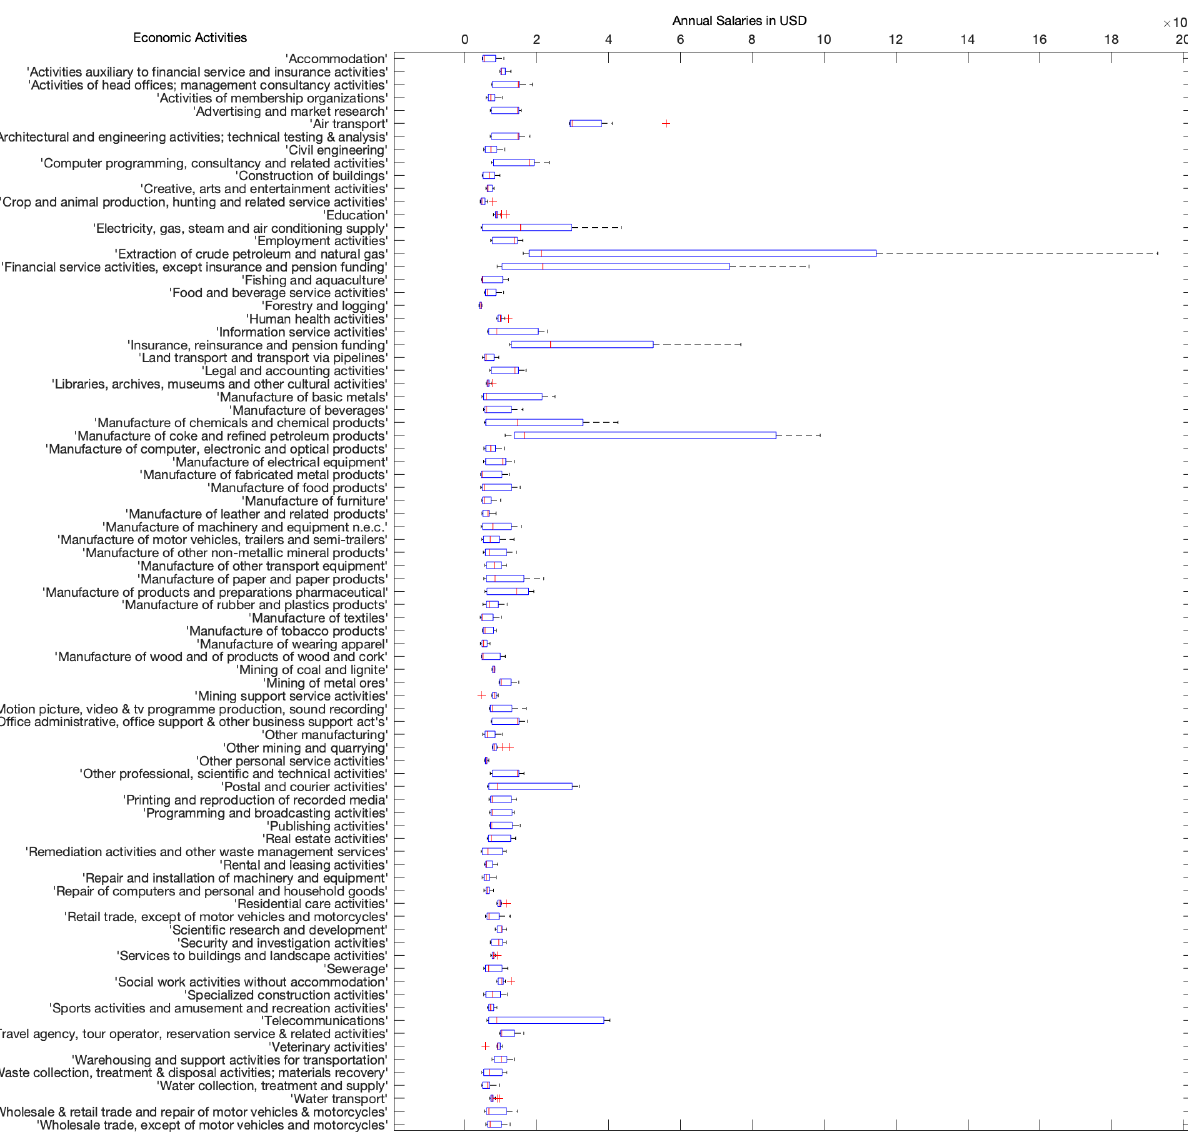
Figure 1. Box plot of mean annual salaries across Saudi national economic activities (2010–2017)